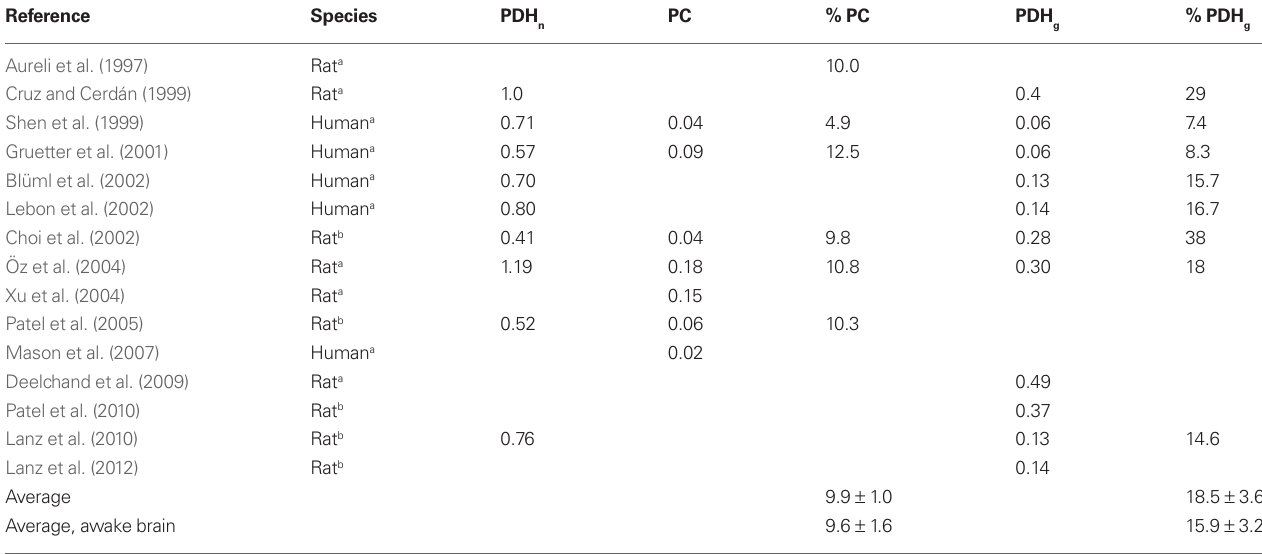
Table 1 | Representative values for metabolic fluxes in human and rat brain in vivo.